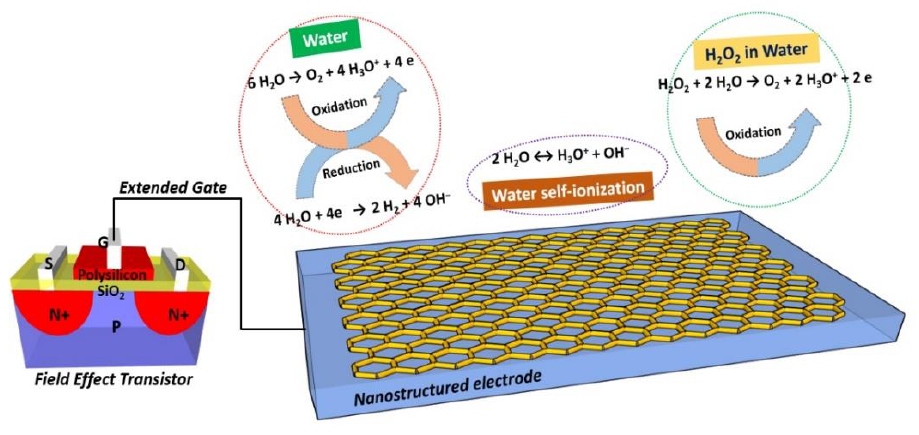
Figure 7. The water-based ion generation during H 2 O 2 detection.